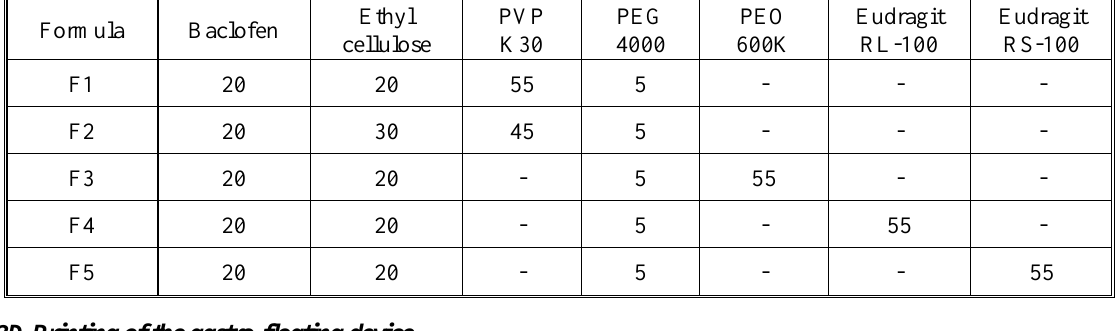
Table 1.Formulations composition for HME tablets (%w/w)